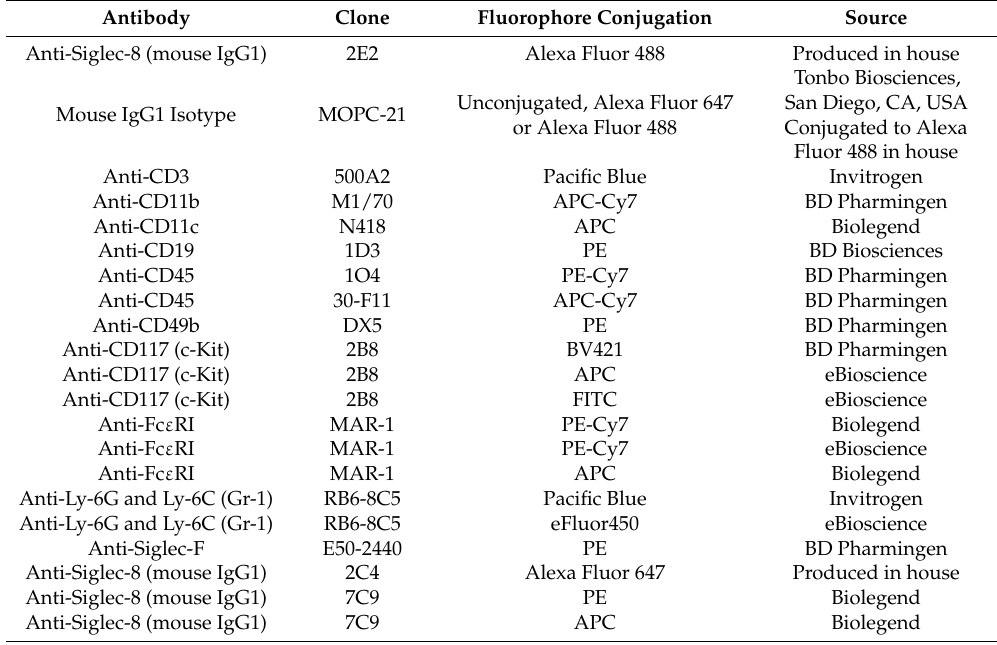
Table 1. Antibody Panel